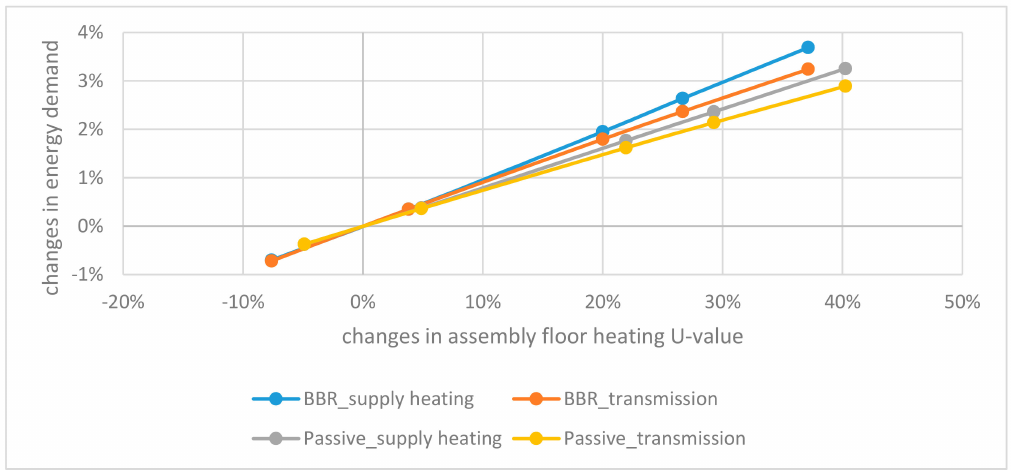
Figure 17. Changes in supply heating demand for space heating due to the di ff erent common floor heating assembly configurations in all studied reference